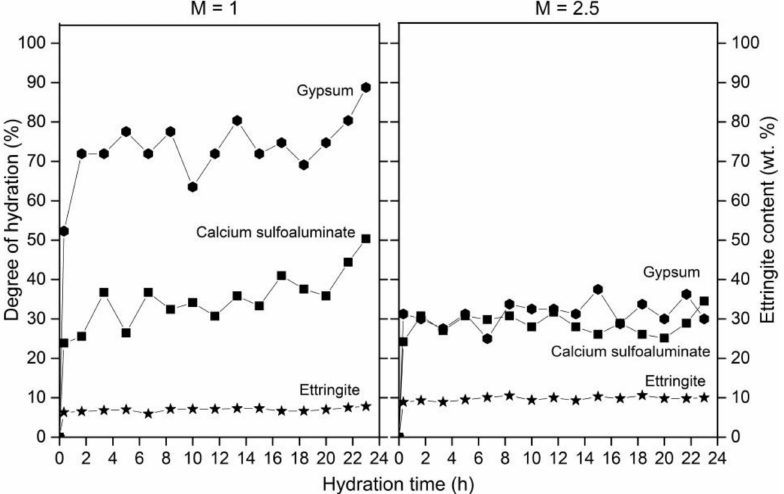
Figure 6. Degree of hydration of calcium sulfoaluminate and gypsum with ettringite content during the first 24 h hydration of the M = 1 and M = 2.5 samples at 40 ◦